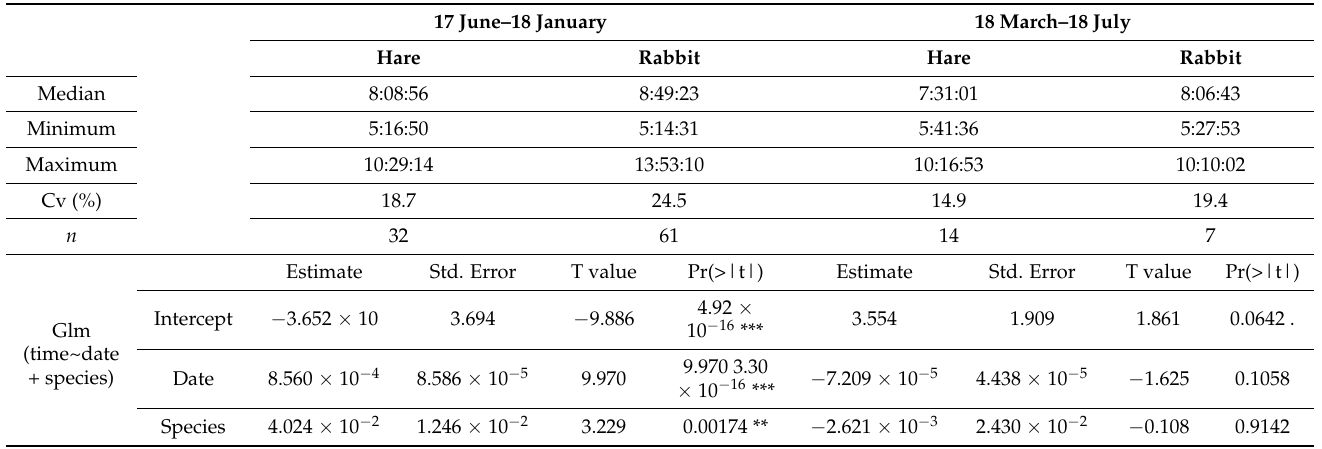
Table 2. Observation times of the Iberian hare ( Lepus granatensis ) and rabbit ( Oryctolagus cuniculus ) registered in a Mediterranean agriculture area in S. Spain. The data correspond to the two periods represented in Figure 6b,c. Signif. codes for Glm: 0 ‘***’, 0.001 ‘**’, 0.01 ‘.’, 0.1 ‘ ’, and